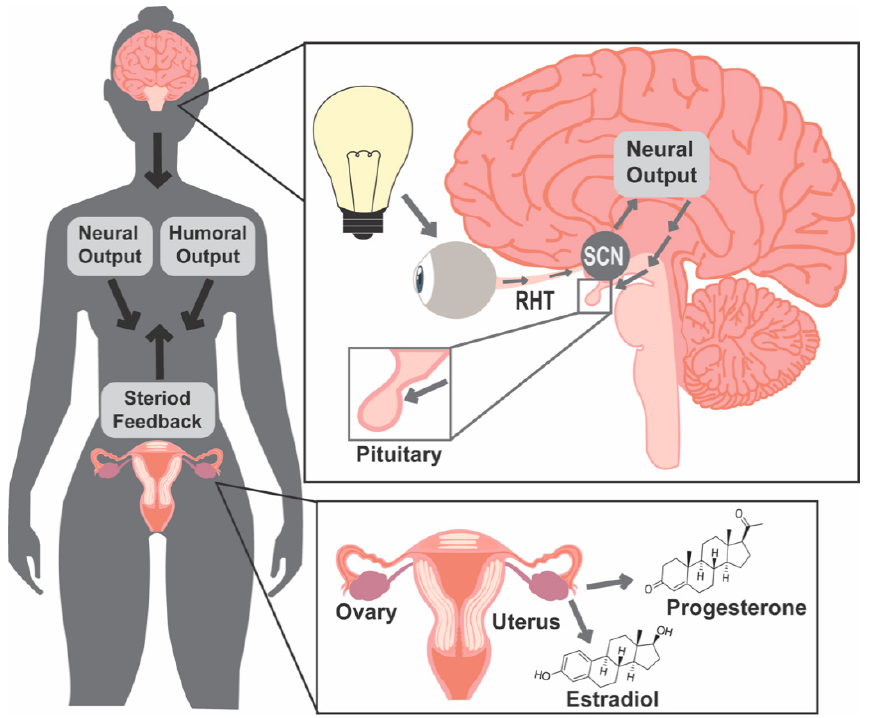
Figure 1. Photic information regulates the female reproductive system. Light enters the eye, where it is captured by the non-vision, intrinsically photosensitive retinal-ganglion cells (ipRGCs) of the retina. Photic information is transmitted directly from ipRGC’s, through the retinohypothalamic tract (RHT), to the brain, including the suprachiasmatic nucleus (SCN) of the hypothalamus. The SCN translates light information and sends signals to non-SCN brain areas and peripheral tissues via neuronal and humoral pathways, allowing target tissues to entrain to time of day. In turn, reproductive tissues, including the ovary and uterus, respond to such cues. The ovary provides steroid hormone feedback to this axis through estrogens and progesterone, which can modulate behavior as well as the timing of central and peripheral clock